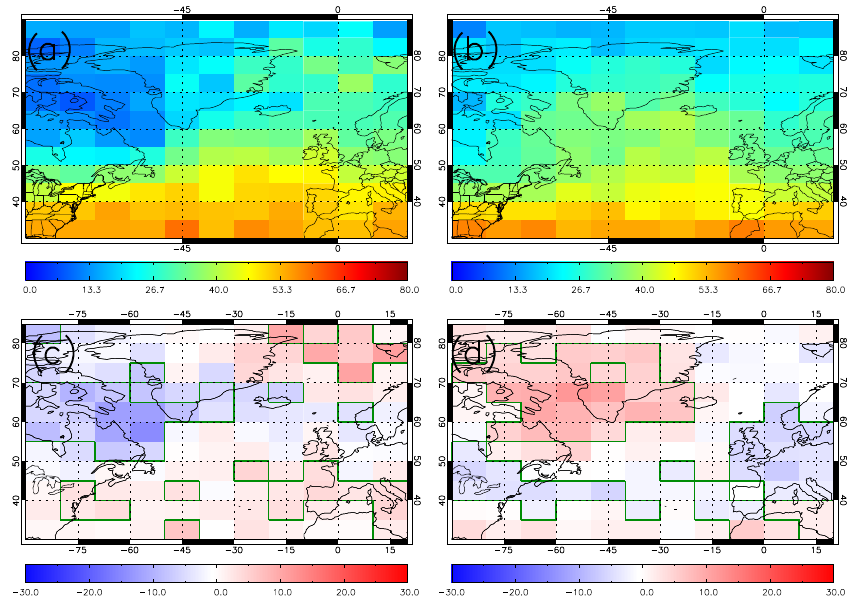
Figure 3. Michelson Interferometer for Passive Atmospheric Sounding (MIPAS) peroxyacetyl nitrate (PAN;pptv) averaged between 200 to 100hPa for 2002–2012. Panel (a) shows PAN sampled under the wintertime (NDJF) NAO positive phase, (b) shows PAN sampled under the wintertime NAO negative phase, (c) shows the positive NAO phase anomaly relative to the wintertime average and (d) shows the negative NAO phase anomaly relative to the wintertime average. Green polygon-outlined regions highlight significant differences at the 95% confidence level based on the WRT.